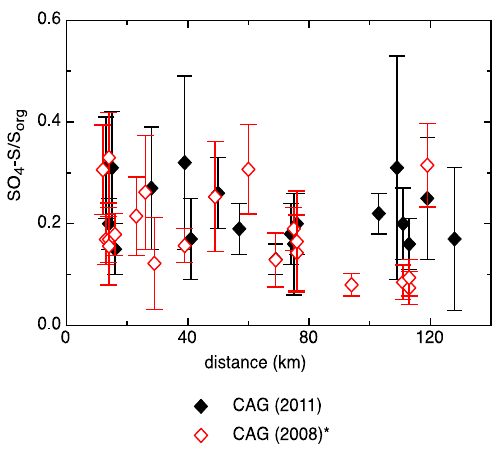
Figure 5. Site averaged SO 4 -S to S org ratios for CAG needles (2011, this study) in comparison to 2008 CAG ratios of jack pine needles (* data from [24]) versus distance to the main oil sands operations.